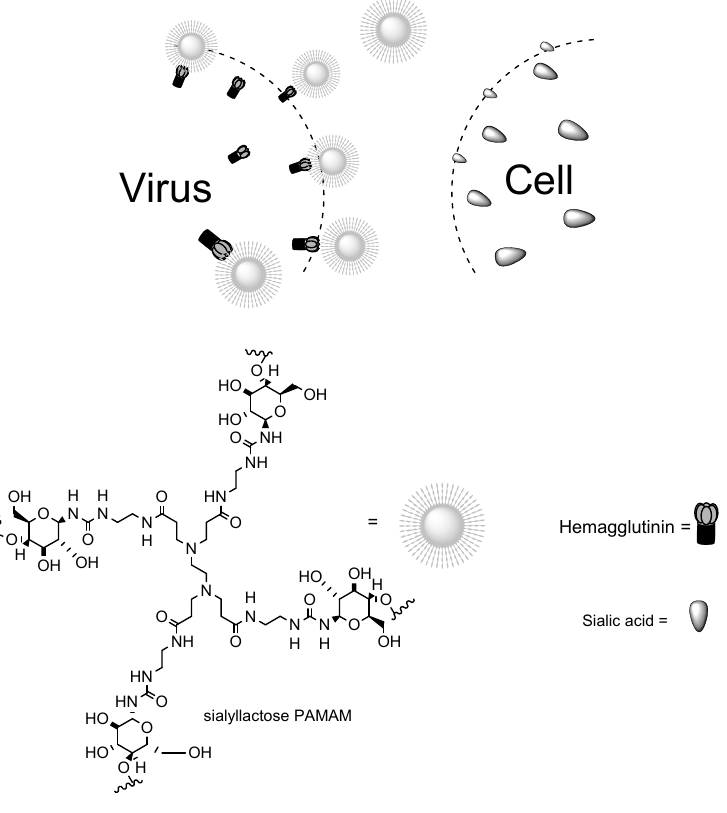
Figure 8. Cell-PAMAM competition for the hemagglutinin site of the virus.